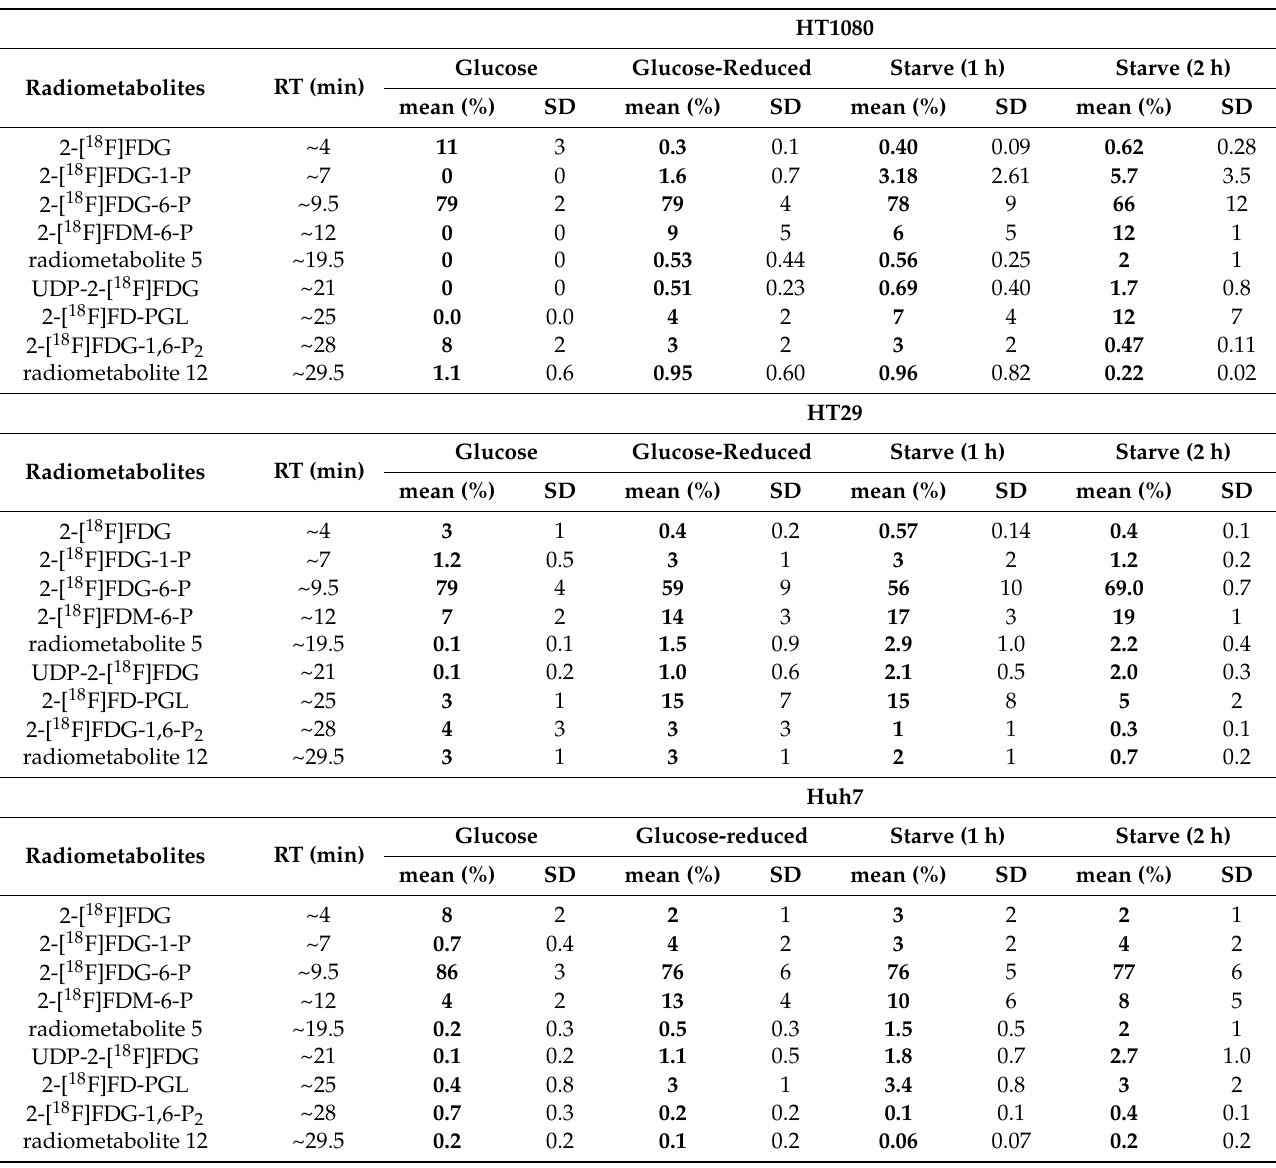
Table 1. Mean radiometabolite formation (%) under different conditions in HT1080, HT29 and Huh7. Conditions: glu- cose = 1.13 g/L, glucose-reduced = 0.13 g/L, starve = glucose-reduced medium 1 or 2 h prior to 2-[ 18 F]FDG addition. Radiometabolites at ~6, ~22, ~23.5 and ~27 min were excluded due to their negligible